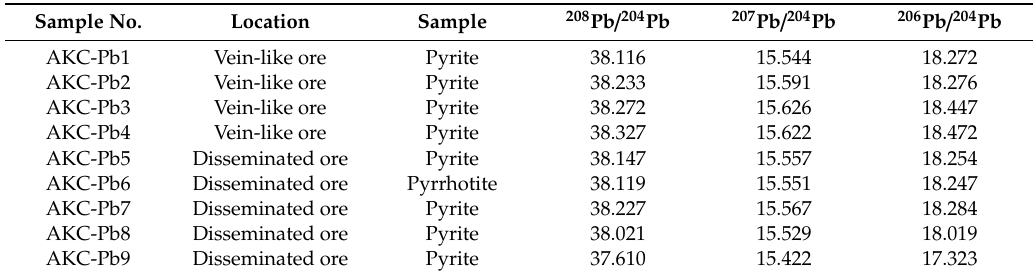
Table 5. Pb isotopic composition of the sulfides from the No.IV mafic -ultramafic complex. Sample